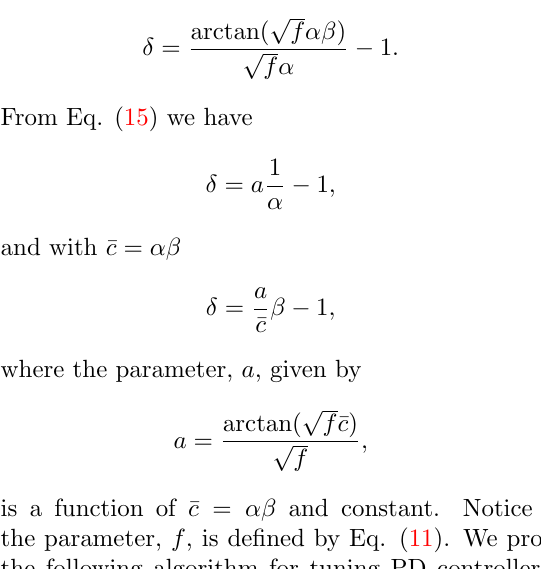
Algorithm 2.1 (Max time-delay error tuning)